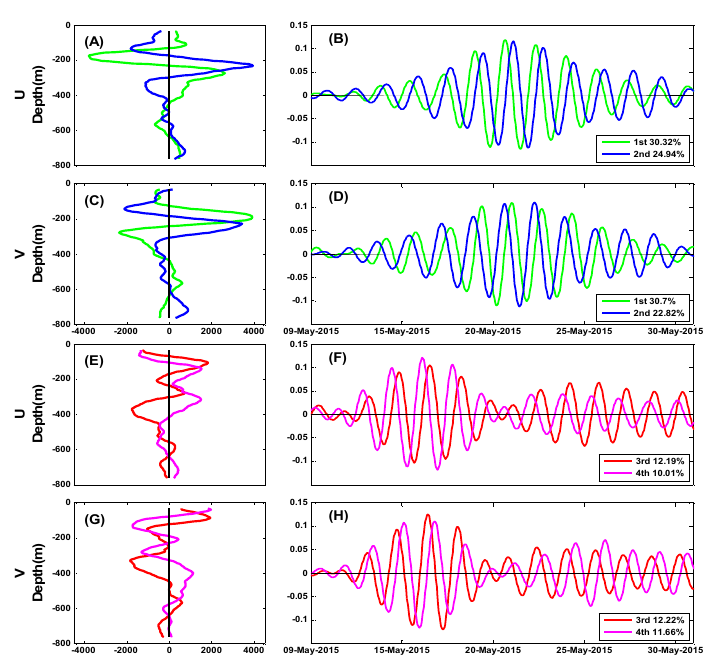
Figure 10. As for Figure 8 but for the NIO event in May 2015.